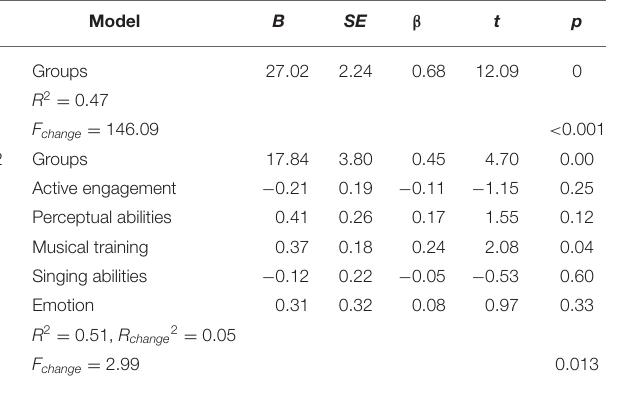
TABLE 4 | Multiple linear regressions for accuracy of tone identification in Model 1 (Groups as the predictor) and Model 2 (Groups + five sub-scales as the predictors).